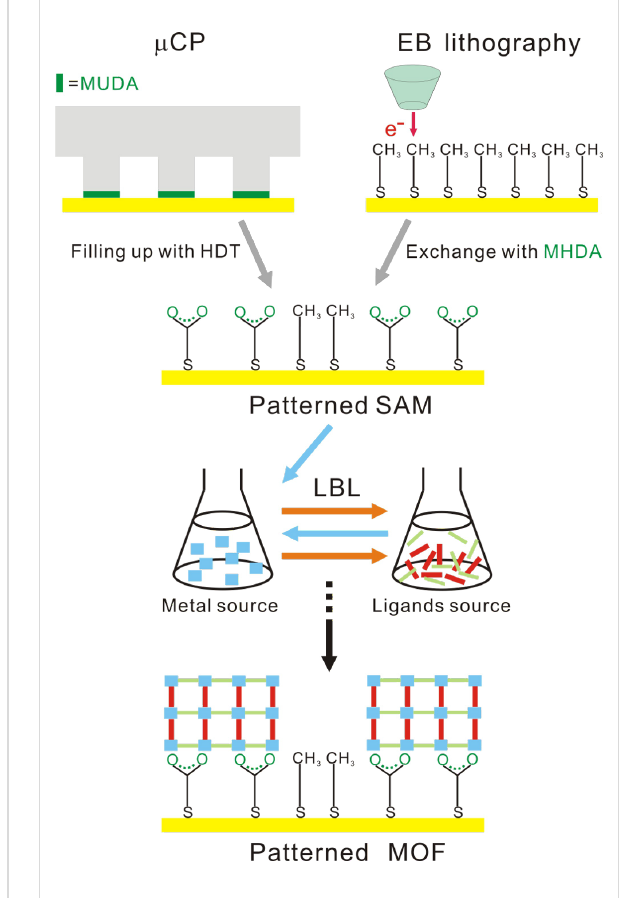
Figure 6: SAMs can be either patterned by µCP (top row, left) or by EB lithography (top row, right) before the layer-by-layer deposition of [Zn 2 (adc) 2 (dabco)]